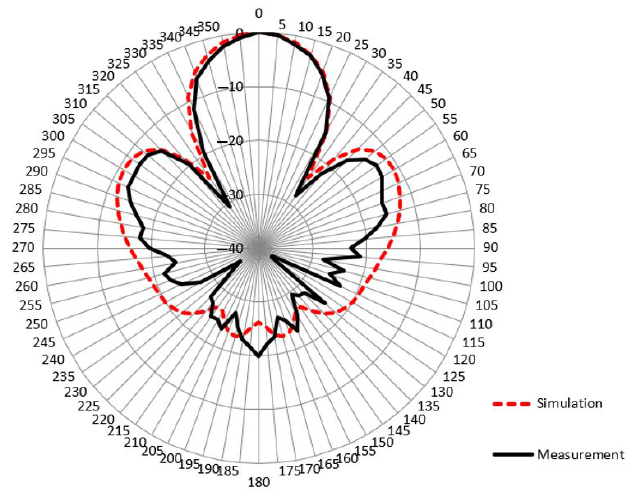
Figure 4. E-plane radiation pattern at 4.148